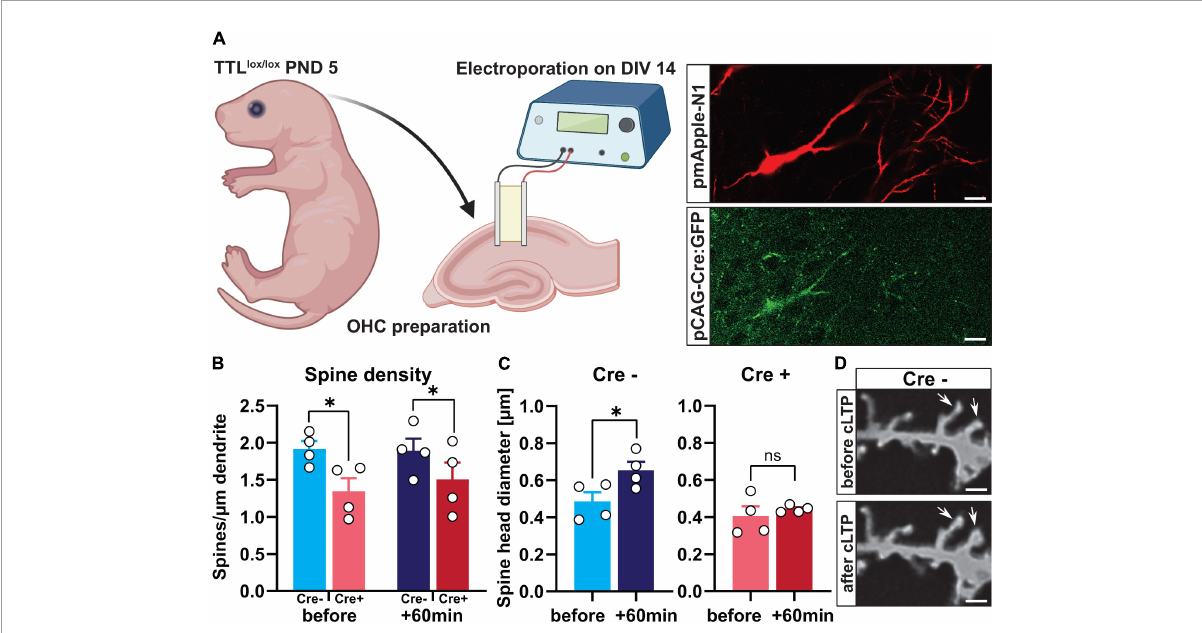
FIGURE6 Single-cell deletion of TTL in hippocampal slice cultures impairs activity-dependent structural plasticity. (A) Schematic representation of single-cell deletion of TTL in hippocampal slice cultures derived from TTL lox / lox mice at postnatal Day 5. Cells were transfected with pmApple-N1 and pCAG-Cre:GFP plasmids by single-cell electroporation (a scale bar = 20 µ m) (the figure was generated using BioRender.com). (B) Assessment of dendritic spine density showed that acute depletion of TTL in Cre + cells resulted in a significant reduction in the number of dendritic spines compared with control Cre- cells, but cLTP induction did not trigger new spine formation ( N = 4 in each group). (C,D) Sixty minutes after cLTP induction, Cre- control neurons showed a significant increase in a spine-head diameter, which was not the case in Cre + cells lacking TTL (C) . Representative examples of dendritic spines in Cre- control cells before and after cLTP induction are shown (60 × ); scale = 2 µ m (D) . N = 4 cells in each group and 15 spines along each dendrite were randomly selected, measured, and averaged for head diameter assessment. Data are presented as mean ± SEM, ∗ p <